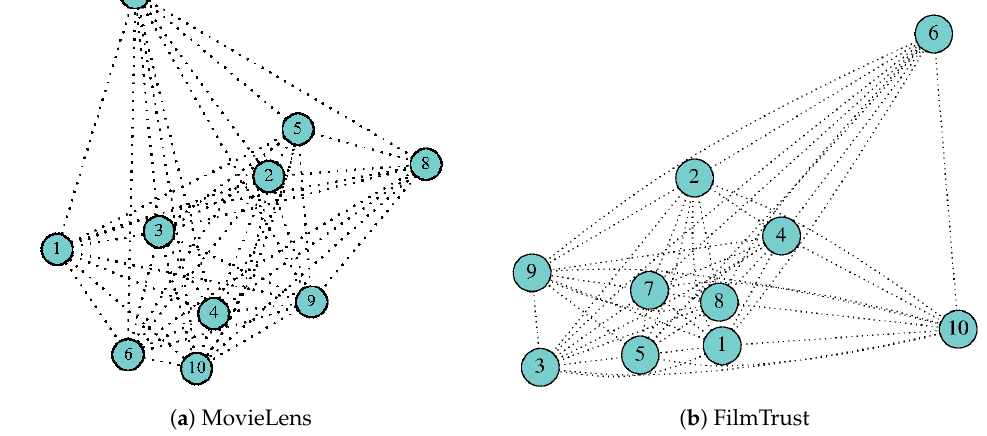
Figure 7. Graphical representation of the distances between the best individuals of each execution of EMF for the ( a ) MovieLens and ( b ) FilmTrust datasets. The length of the edges is proportional to the L 2 distance between the corresponding aggregate functions. The mean distance in the MovieLens graph is 70% bigger than the mean distance in